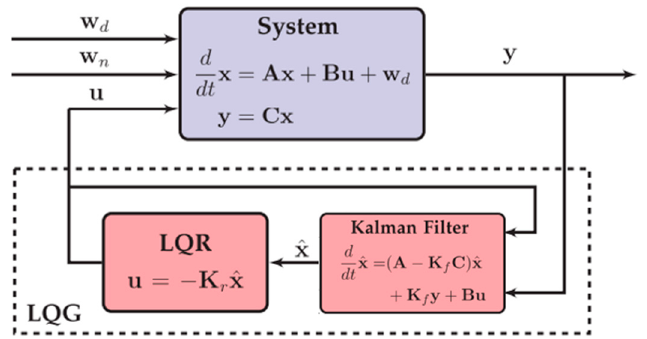
Figure 8. Linear Quadratic Gaussian.